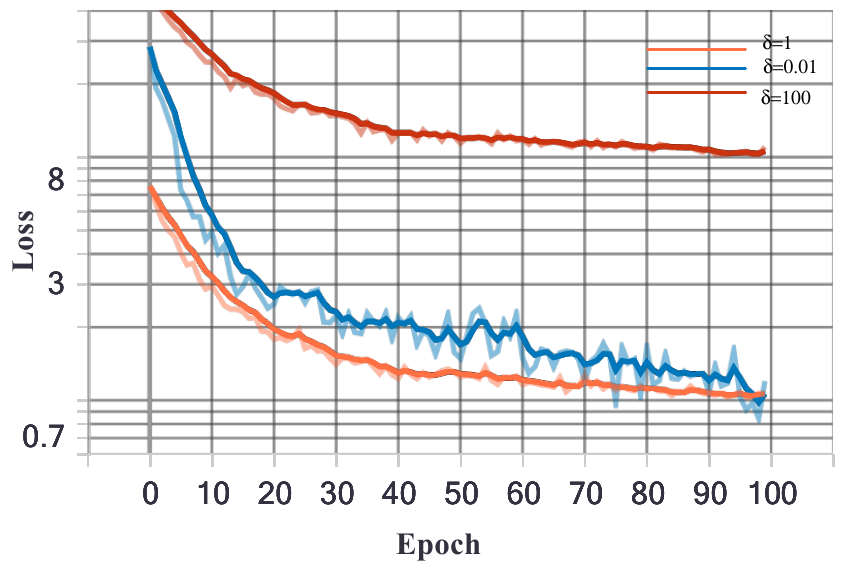
Figure 6. Training loss curves on different rations δ between balanced coefficients ( α , β ) of the total loss function Equation (8). The rations δ include 1,0.01, and 100 and these ratios denote ( α , β ) is ( 1,1 ) , ( 0.1,10 ) , ( 10,0.1 )